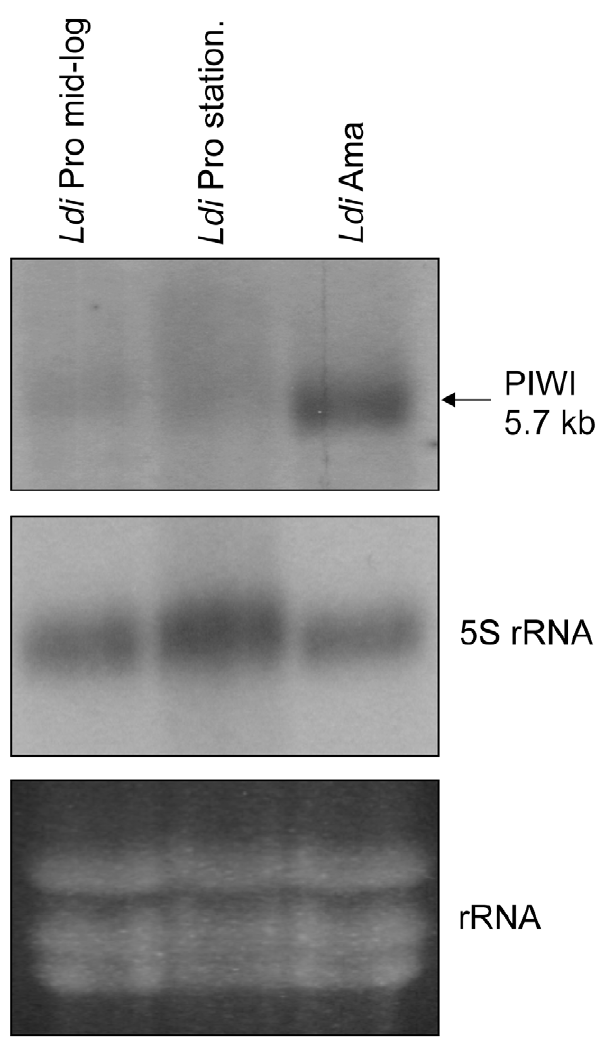
Figure 2. The Leishmania PIWI transcript is preferentially expressed in the amastigote lifestage. Northern blot hybridization to measure expression of the L. infantum LinPIWI transcript in exponentially- and stationary-grown promastigotes (Pro) and also in axenic amastigotes (Ama). The 5S rRNA probe was used for normalization of RNA loading. Northern blot experiments have been repeated two more times with identical results.